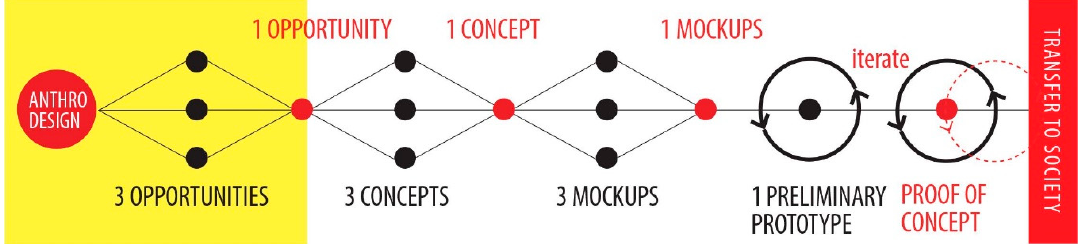
Figure 1. The Anthro-design process based on human oriented research (Miranda, 2019) [17].